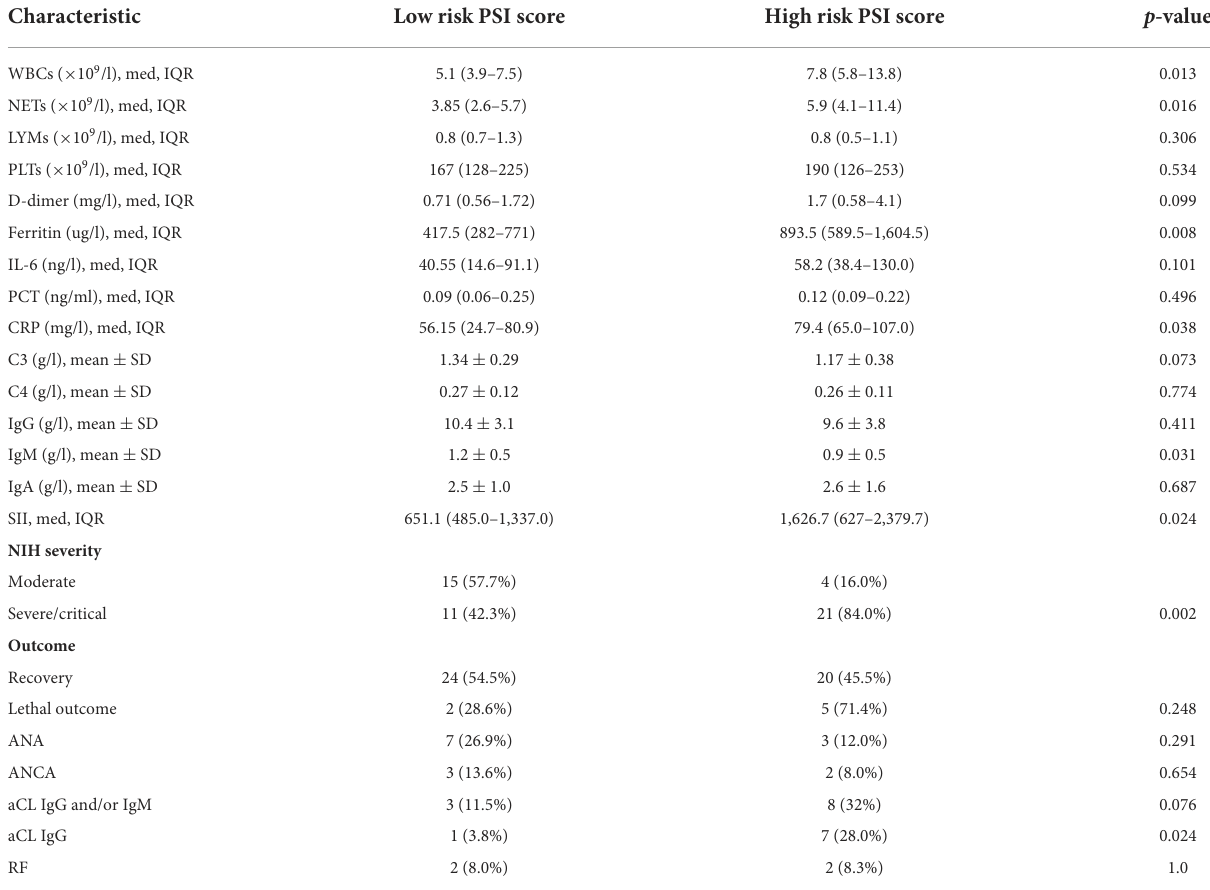
TABLE 3 Relevant comparisons according to the pneumonia